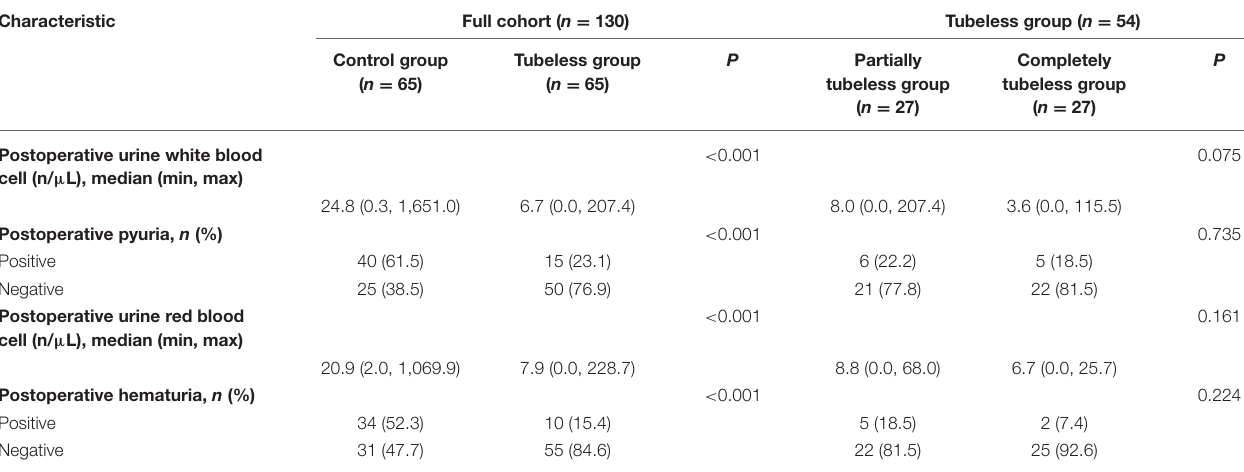
TABLE 2 | Urine laboratory examination of our study population after